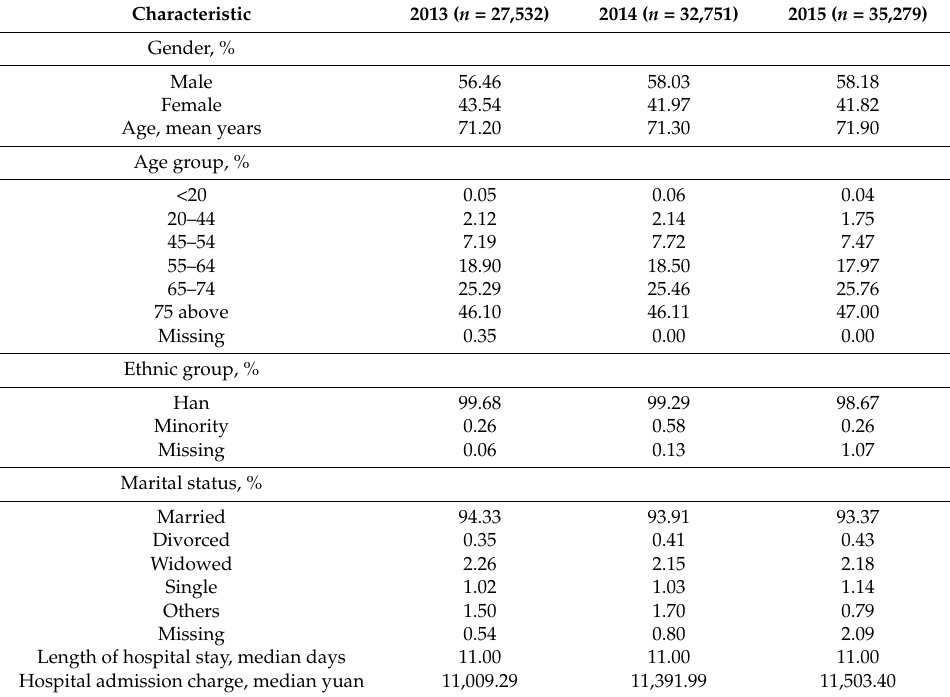
Table 1. Basic characteristics of ischemic stroke patients by calendar year in Guangzhou during the time period of